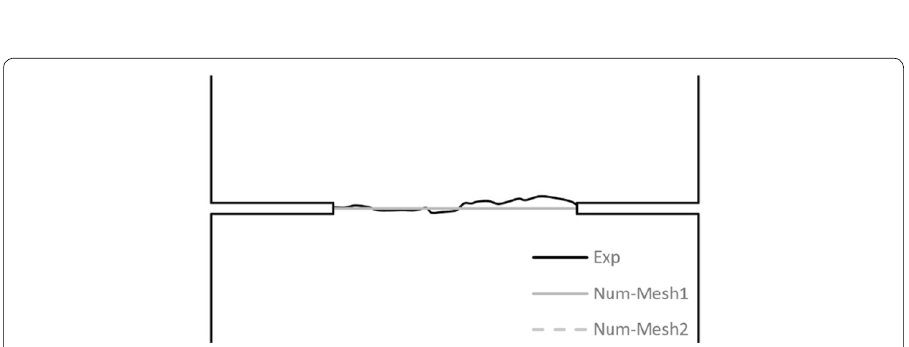
Fig. 10 Comparison of numerical and experimentally observed crack